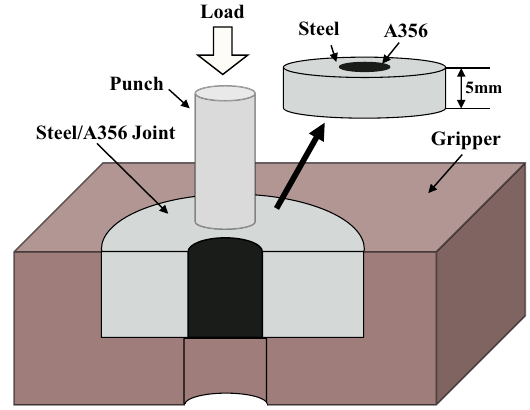
Figure 2: Schematics diagram of the push - out tests.